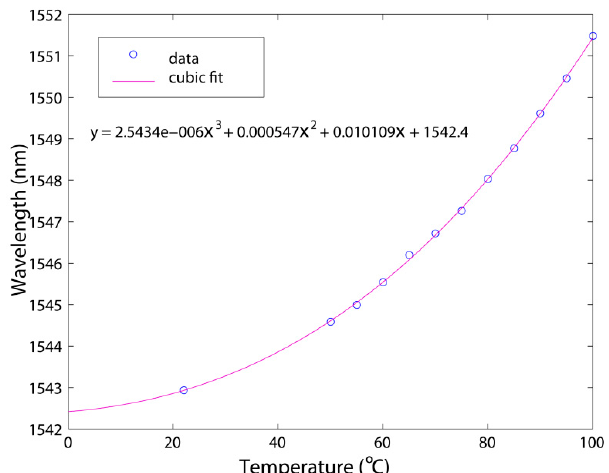
Figure 4. Measured wavelength shifts at different temperatures. Copyright (2010) Optical Engineering, from Reference [48].